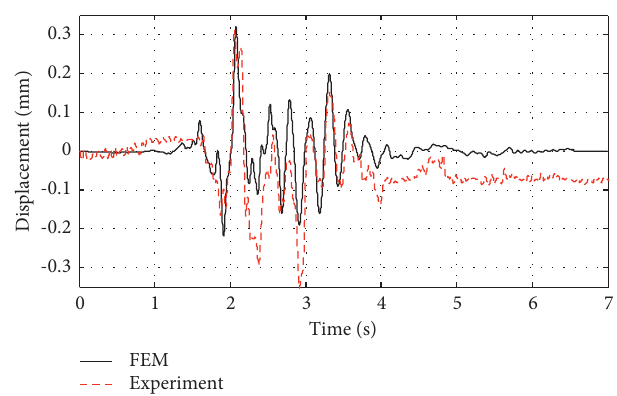
Figure 21: Joint deformation of experiment and FEM (J1, Vp � 600m/s).